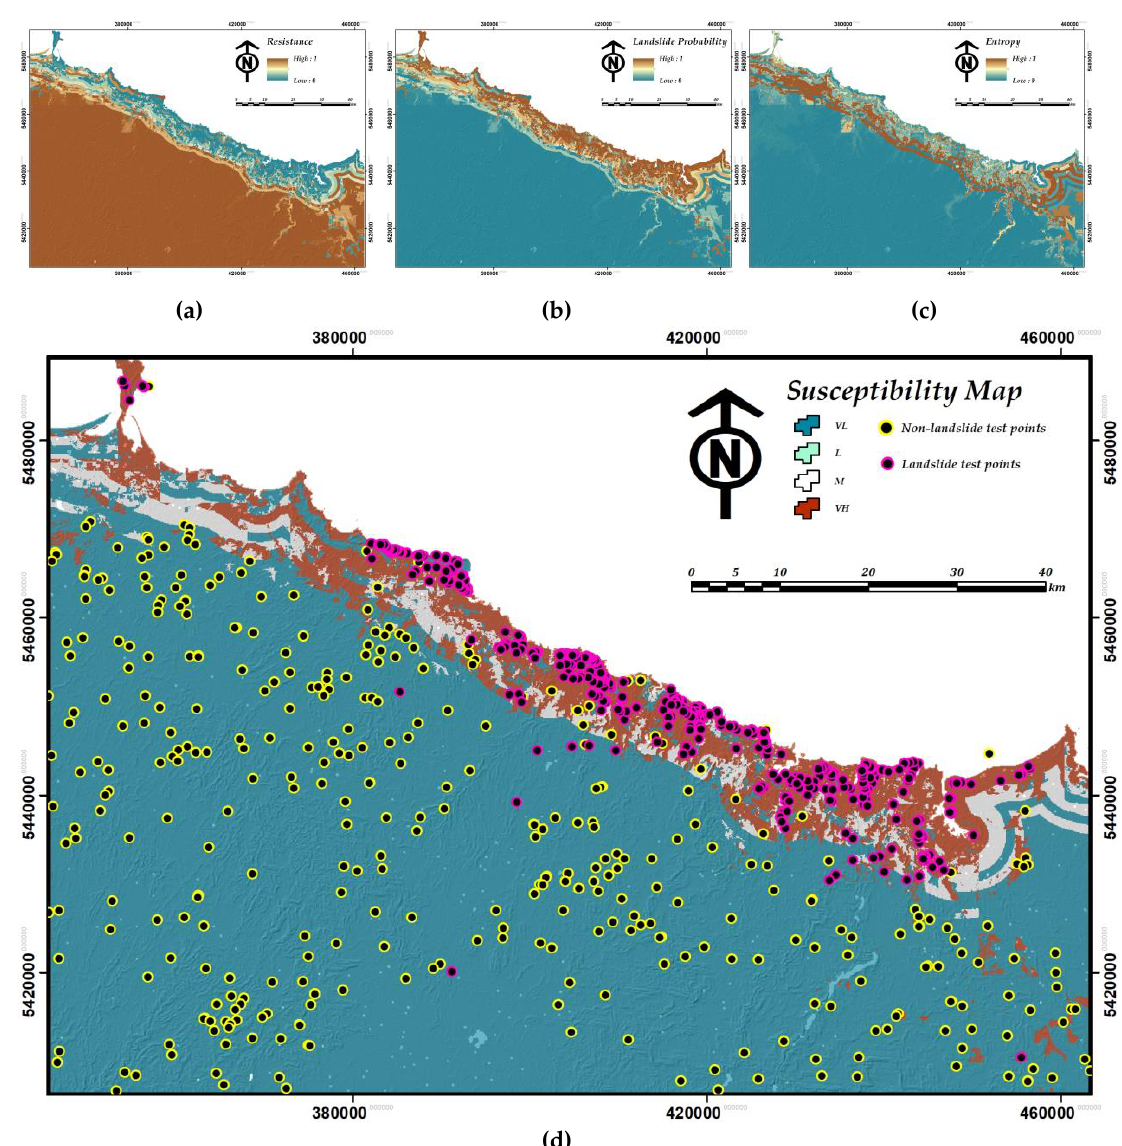
Figure 5. Achieved results of methodology implementation including ( a ) non-landslide occurrence probability (resistance), ( b ) landslide probability, ( c ) entropy (i.e., uncertainty) of susceptibility mapping, and ( d ) LSM.